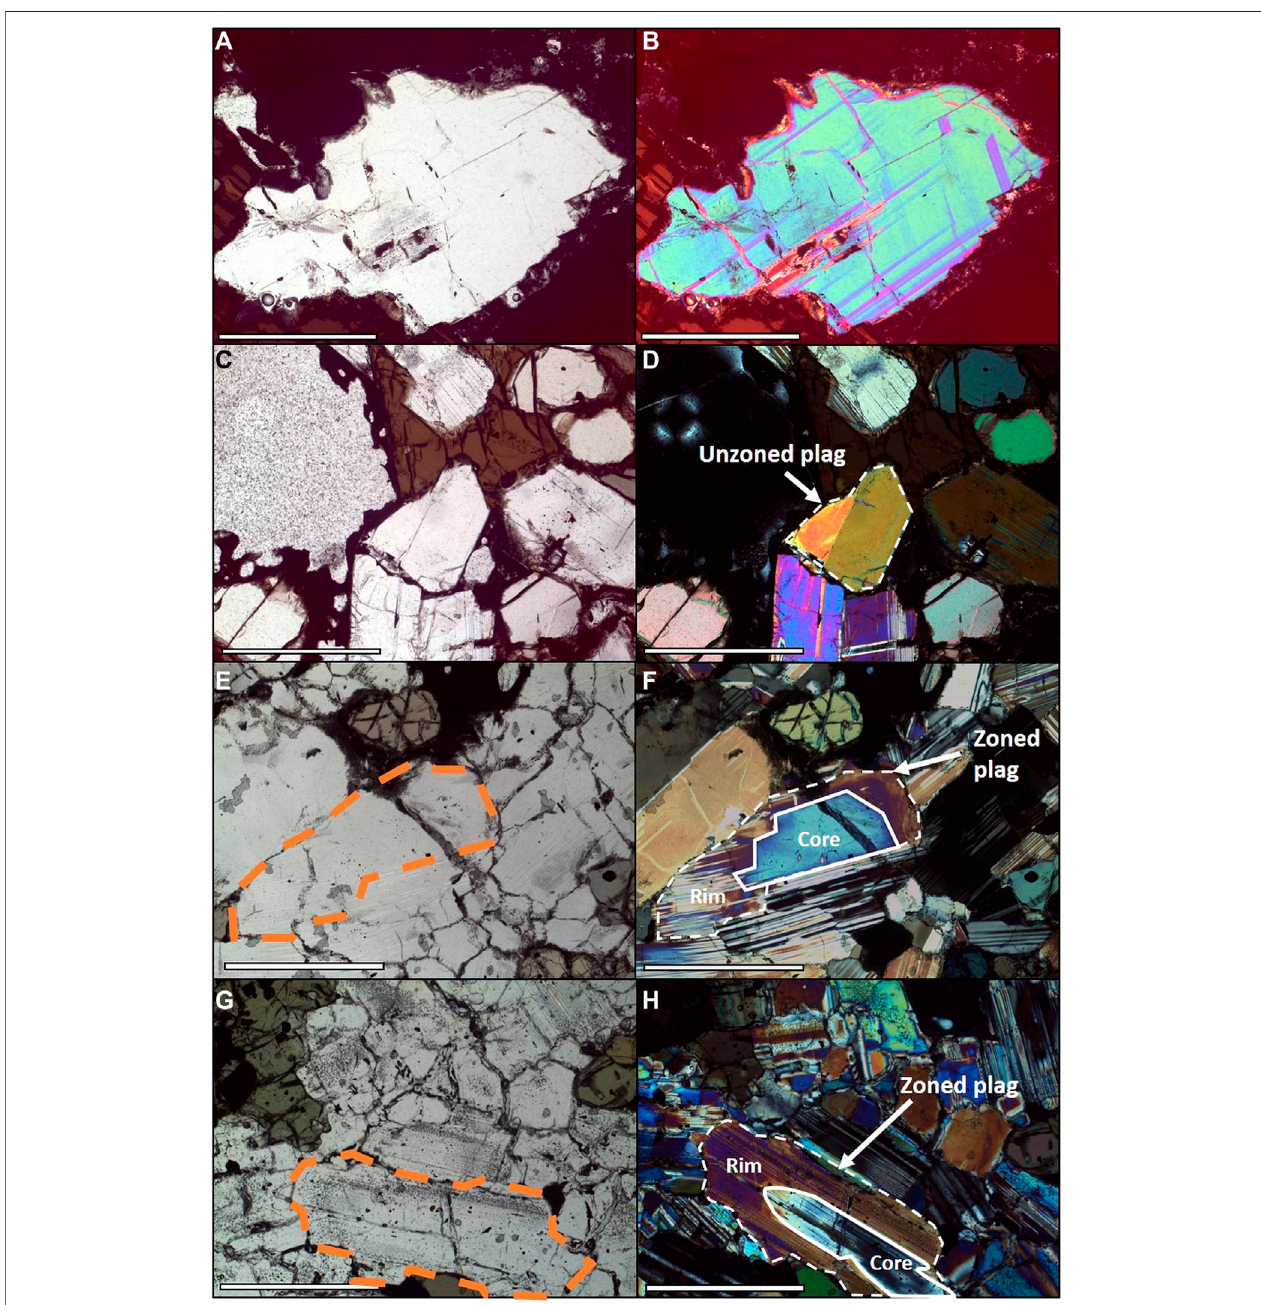
FIGURE 4| (A) and (B) Typical unzoned cumulate plagioclase from sample MQ59. (C) and (D) Typical unzoned cumulate plagioclasefrom sample MQ48. (E) and (F) Typical zoned plagioclase in NCG sample MQ35. (G) and (H) Typical zoned plagioclase in NCG sample MQ6. Orange outlines in (E) and (G) highlight labeled zoned plagioclasein (F) and (H) .Images (A),(C),(E) ,and (G) inPPL, (B),(D,)(F) ,and (H) inXPL.Whitescalebar (cid:1) 1 mm.UnusuallyhighbirefringencecolorsinXPLimagesare due to the 100 µm thickness of the